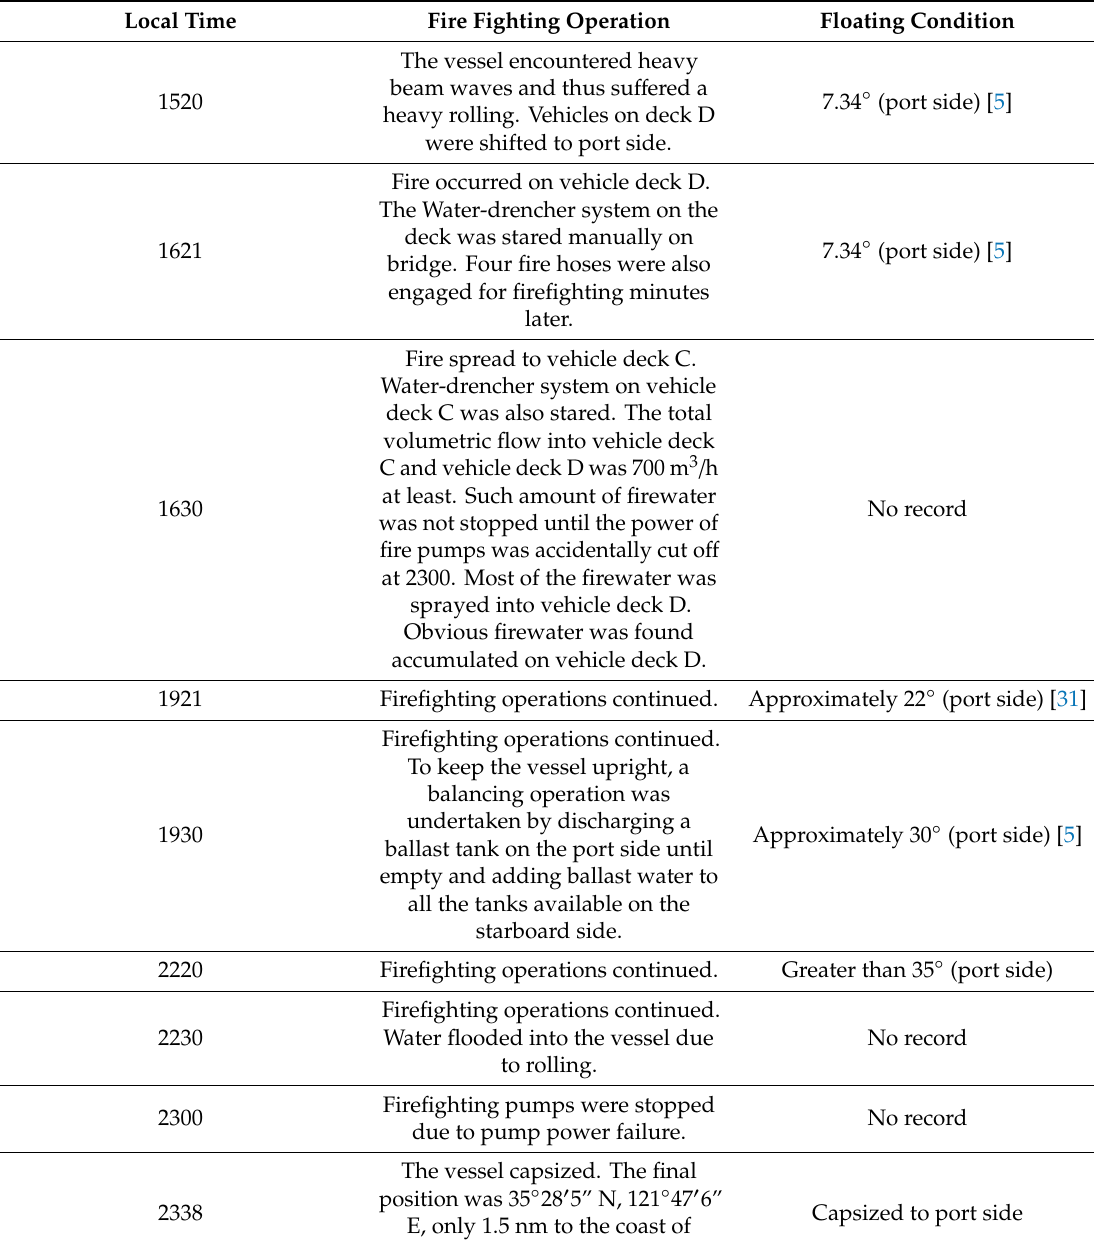
Table 4. A brief description of the accident of the M / V Dashun